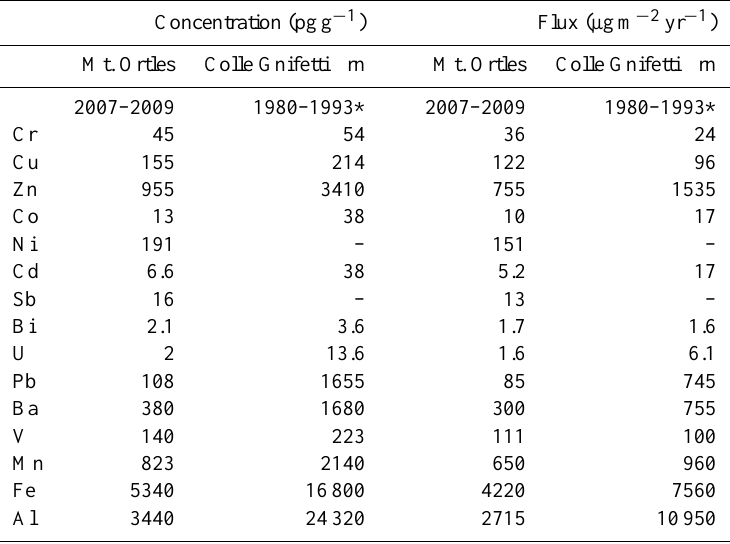
Table 2. Average concentration and fluxes of trace elements in snow samples collected in the Glacier Alto dell’Ortles snow pit and in the Colle Gnifetti firn core, Monte Rosa (Gabrieli,